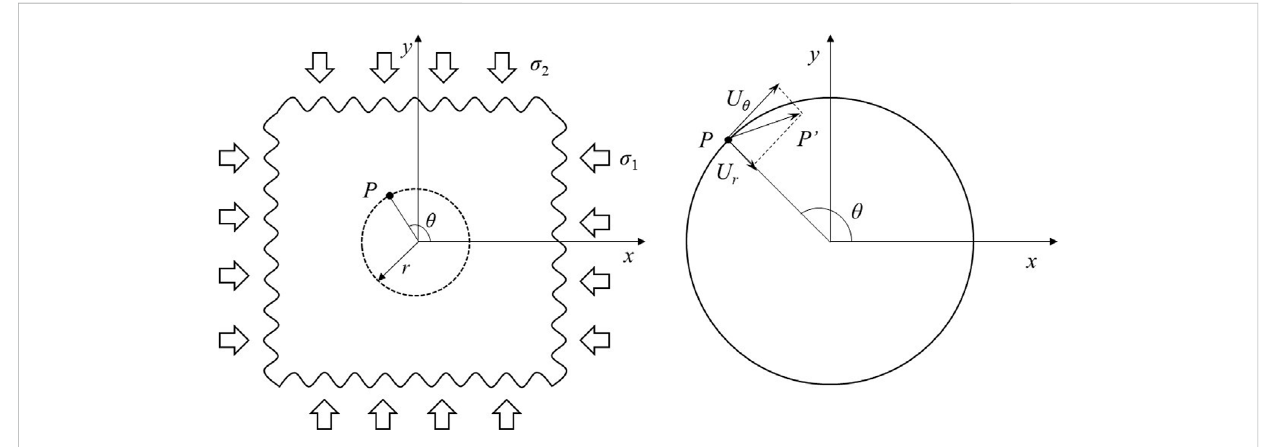
FIGURE 1 Schematic diagram showing the displacement of any point on the borehole wall under two-dimensional stresses.